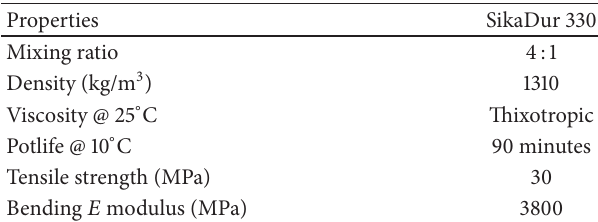
Table 2: Material properties of SikaDur330.